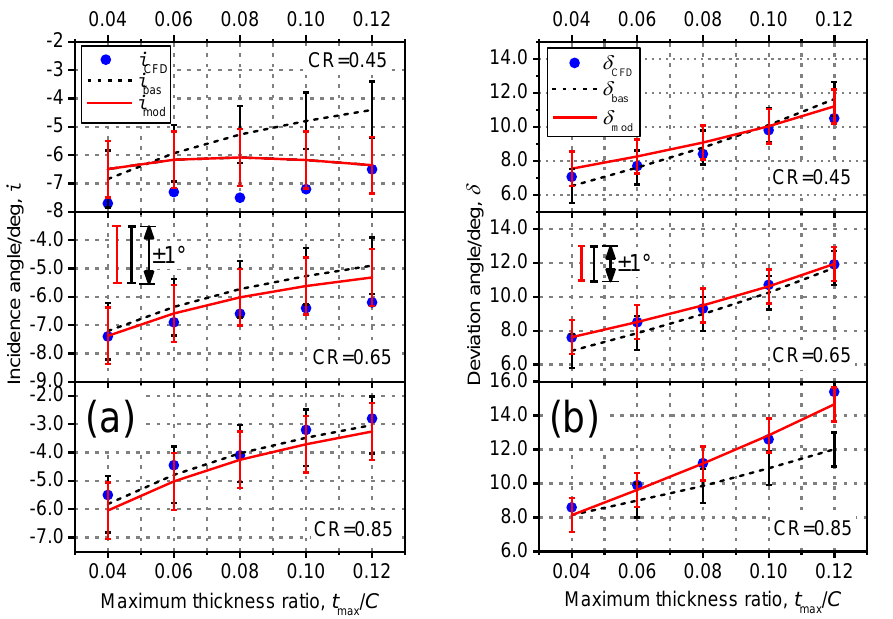
Figure 16. Comparisons between CFD results and modified basic correlations for ( a ) incidence and ( b ) deviation angles.